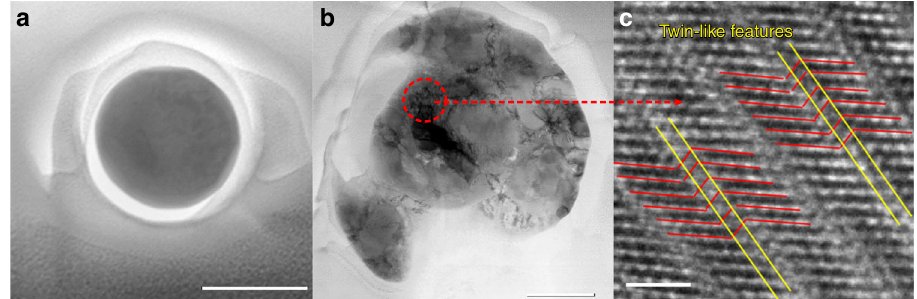
Fig. 2 Characterization of Ni nanoparticles. a Plain view STEM dark fi eld image of a pristine nanoparticle, showing the absence of dislocations or other defects. b STEM dark fi eld image showing numerous defects and twin-like deformation structures after the particle failure. c High-resolution transmission electron microscopy (HRTEM) image from the marked area showing the twin-like structures. The scale bars shown in a , b , and c correspond to 200, 200, and 1 nm, respectively